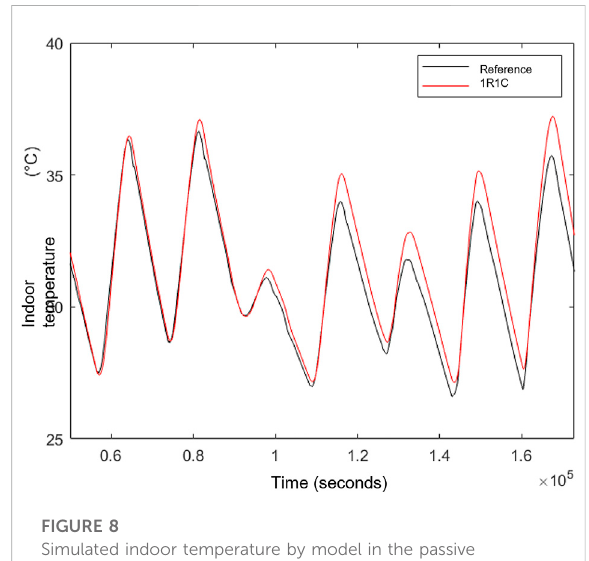
Simulated indoor temperature by model in the passive